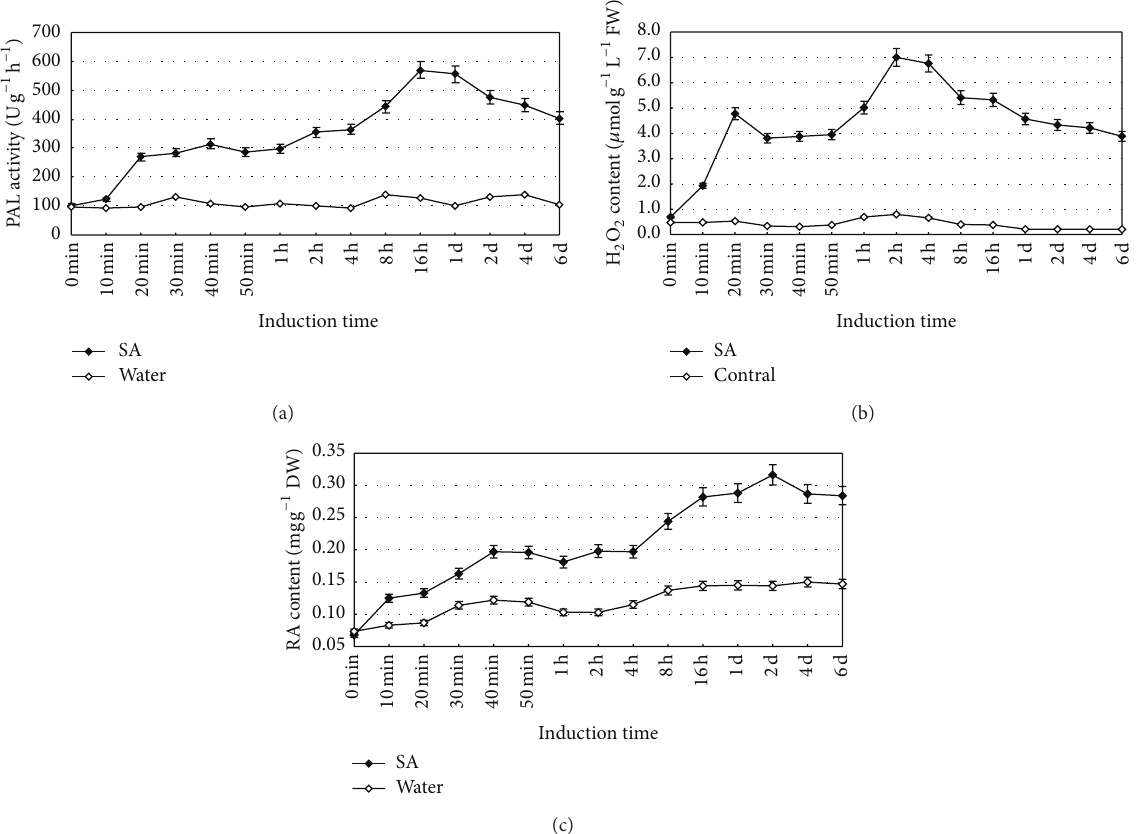
Figure 1: Exogenous SA promotes PAL activity (a), H 2 O 2 production (b) and RA synthesis (c) in the suspension cultured cells of S. miltiorrhiza. 6-day-oldsuspensionculturedcellstreatedwith22.5 mg/LSAwereharvestedatthetimeindicated.ThePALactivityandcontents of H 2 O 2 and RA were determined. Values are means of three independent experiments. Bars represented standard errors.